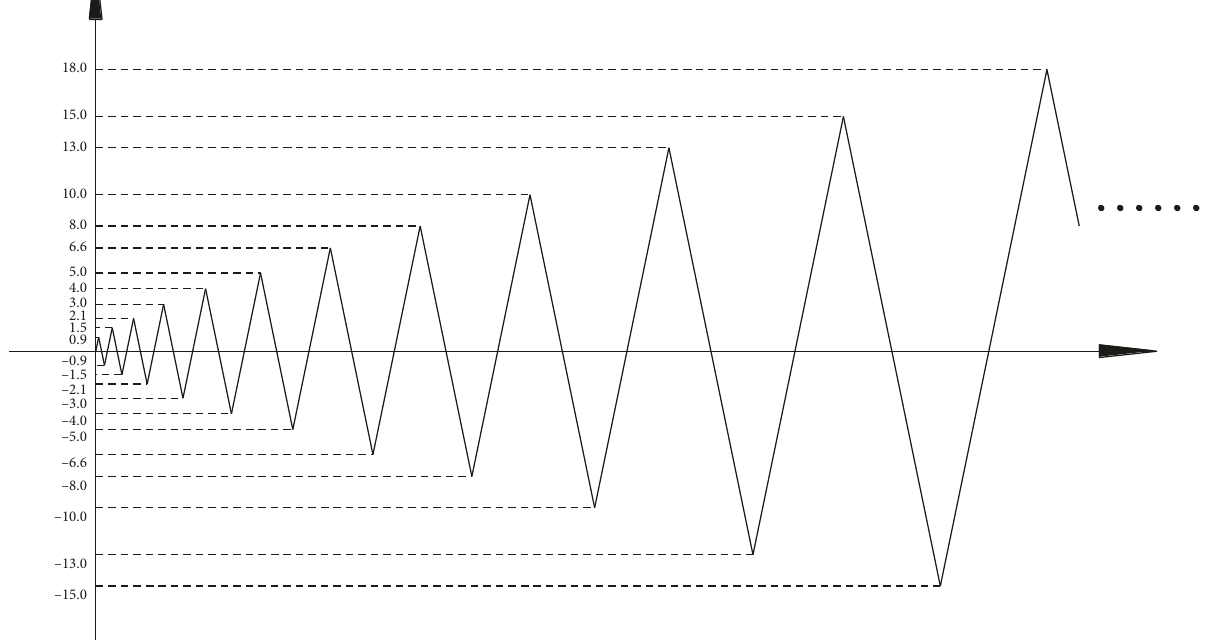
Figure 4: Displacement control loading